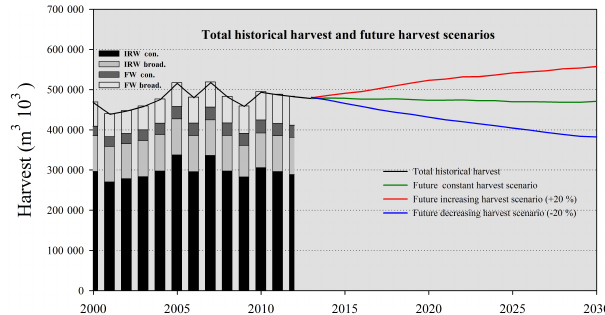
Figure 1. Total harvest demand for EU26 (m 3 10 3 ) for the his- torical period (2000–2012) and for three future scenarios (2013– 2030), assuming average constant harvest, increasing harvest de- mand (i.e., + 20% in 2030) and decreasing harvest demand (i.e., − 20% in 2030). For the historical period, bars show the share of harvest distinguished between industrial roundwood (IRW) and fu- elwood (FW) and conifers (con) and broadleaves (broad). The same ratios, corrected in proportion to the total harvest demand, were ap- plied to each future harvest